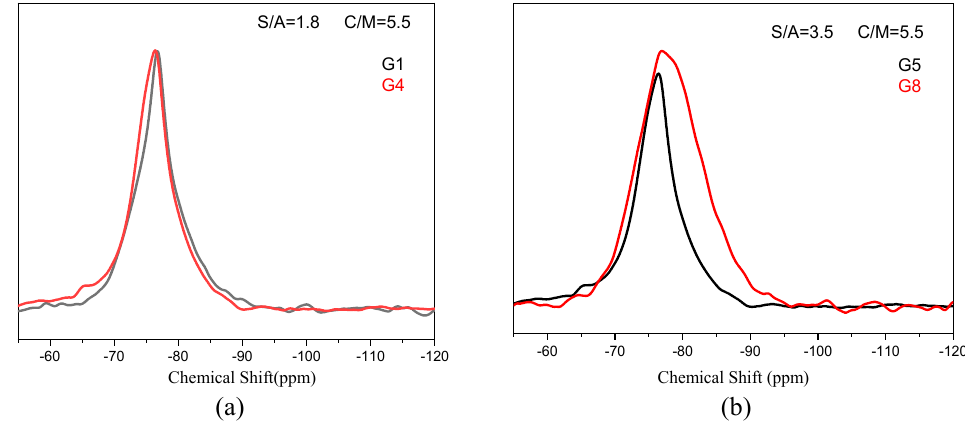
Figure 12. 29 Si MAS NMR spectra of slag with different amorphous content: ( a ) unhydrated G1 and